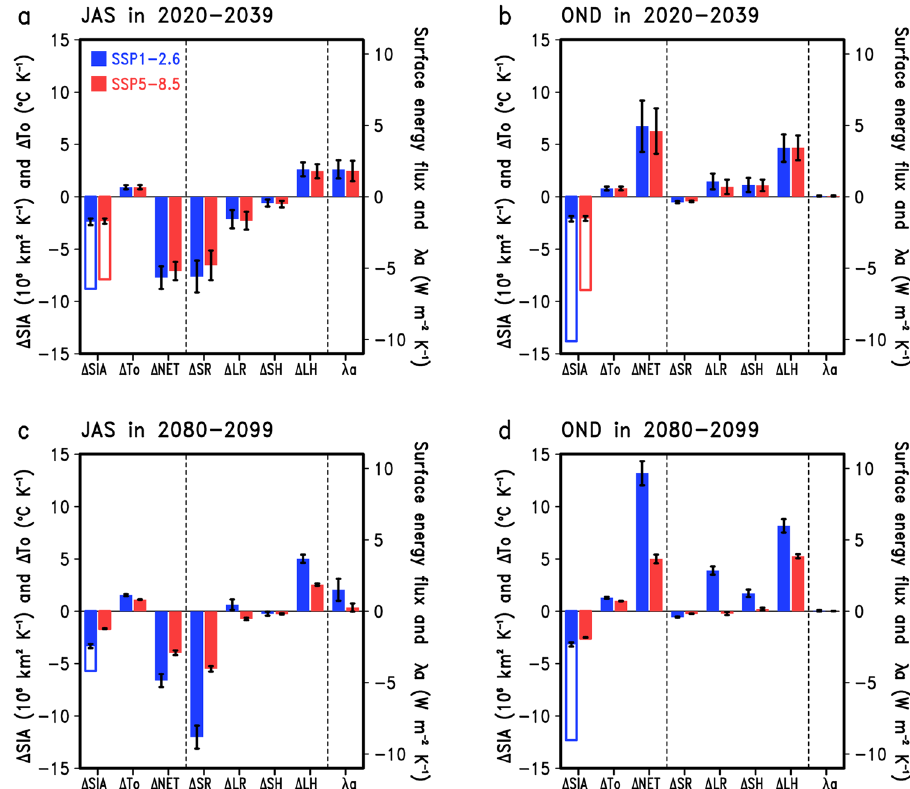
Fig. 3 Changes in the Arctic surface energy budgets in SSP1-2.6 and SSP5-8.5 in MIROC6. a , b Changes in JAS and OND for 2020 – 2039, respectively, in (from left to right) SIA (10 6 km 2 K − 1 ), ocean potential temperature for the upper 200m ( T O , °CK − 1 ), surface net energy fl ux (denoted as NET, Wm − 2 K − 1 ), and individual components of NET (net shortwave radiation, SR, net longwave radiation, LR, sensible heat fl ux, SH, and latent heat fl ux, LH). The ice-albedo feedback parameter for the Arctic region ( λ a , Wm − 2 K − 1 , see “ Methods ” ) is shown on the right. All values are scaled by the global- and annual-mean SAT change (K), and positive values of energy fl uxes represent fl uxes upward from the ocean to the atmosphere. Error bars indicate the 50-member ensemble spread of the 20-year means. Open bars of SIA signify that there is still sea ice remaining, which is calculated assuming the no-ice condition (see caption of Fig. 2 for the de fi nition). c , d As in ( a , b ) but for 2080 –